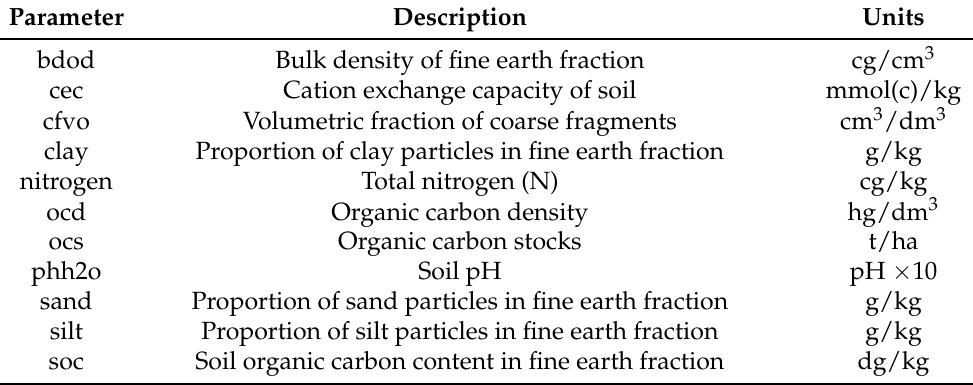
Table 3. Parameters extracted from SoilGrids at 15–30 cm